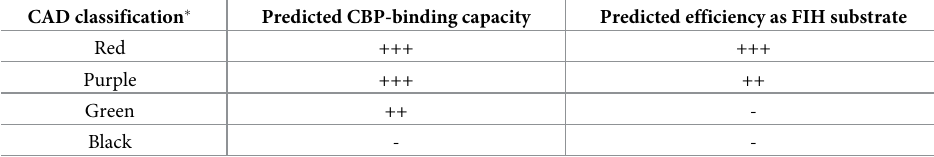
Black Predictions are based on conservation of CBP-binding residues and the FIH preferred target sequence relative to hsHIF-1 α CAD. � Colours defined as for CAD categorisation in Fig